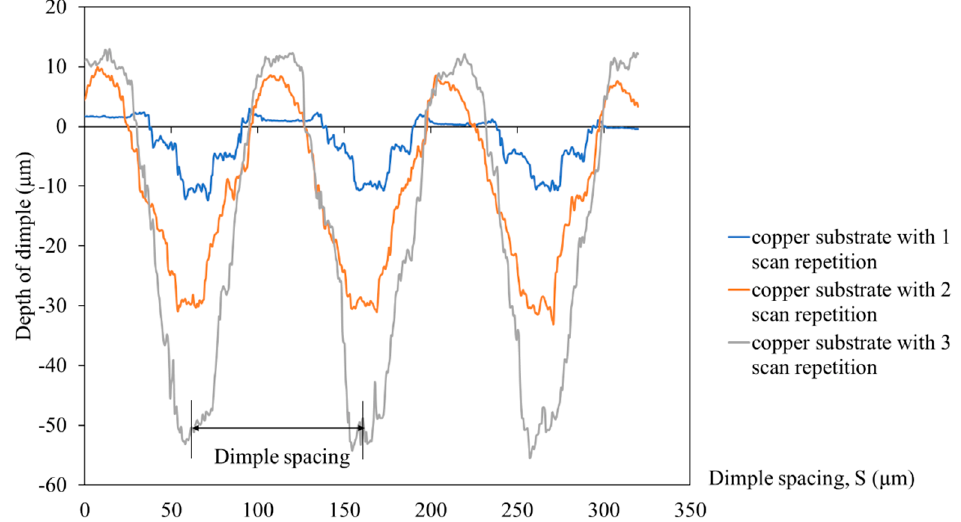
Figure 5. Surface profiles of the dimple − microtextured copper substrate with a different number of laser scan repetitions.